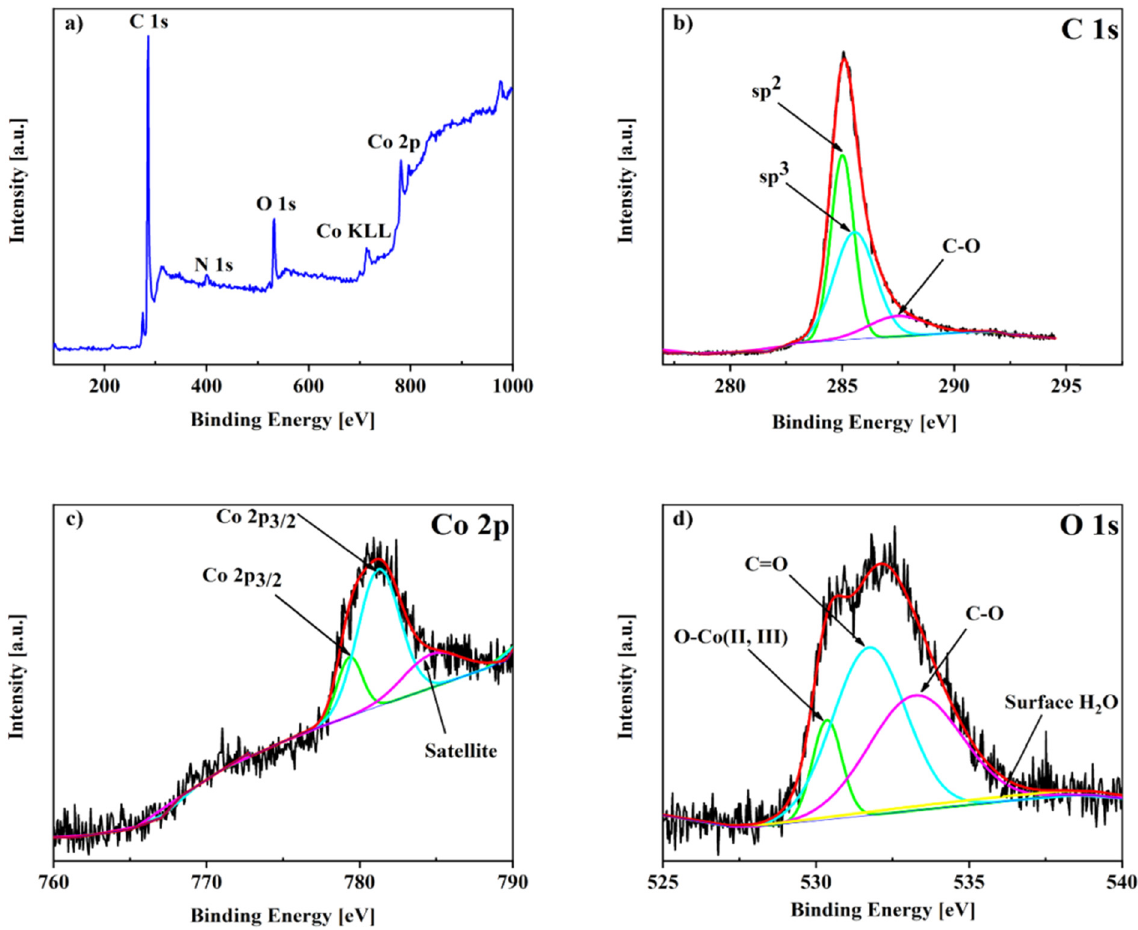
Figure 4: ( a ) General XPS spectrum and deconvoluted XPS spectra of ( b ) C 1 s, ( c ) Co 2p, and ( d ) O 1 s for 0.5 Co 3 O 4 /ECNF - 5h